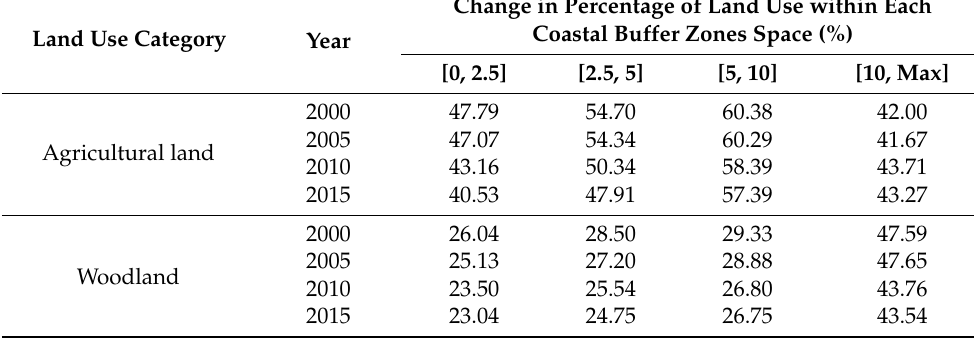
Table 3. Changes in coastal land use gradients in